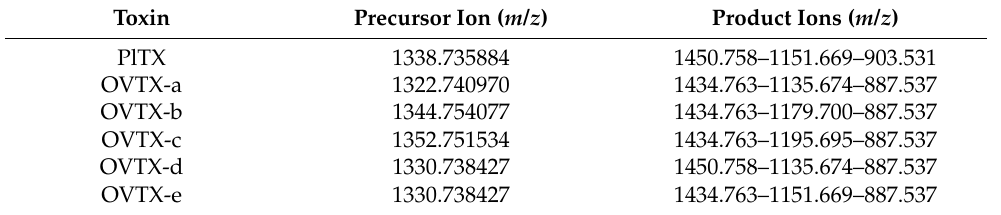
Table 1. Precursor and product ions of palytoxin analogs.